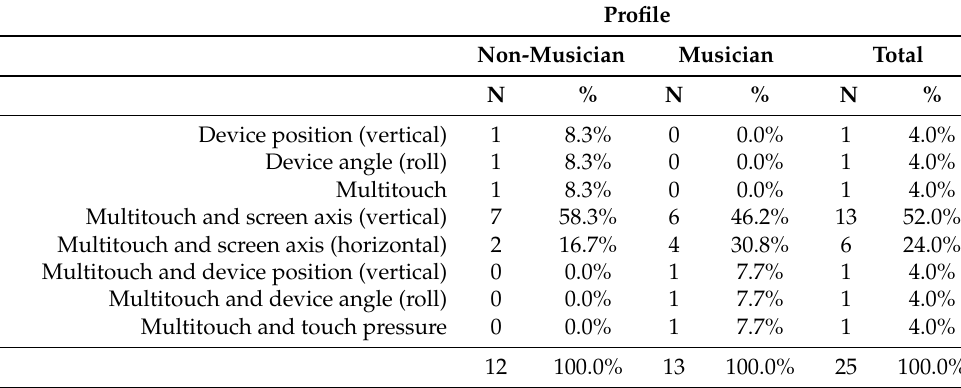
Table A9. Polyphony mapping (uncategorized)—stimulus e.